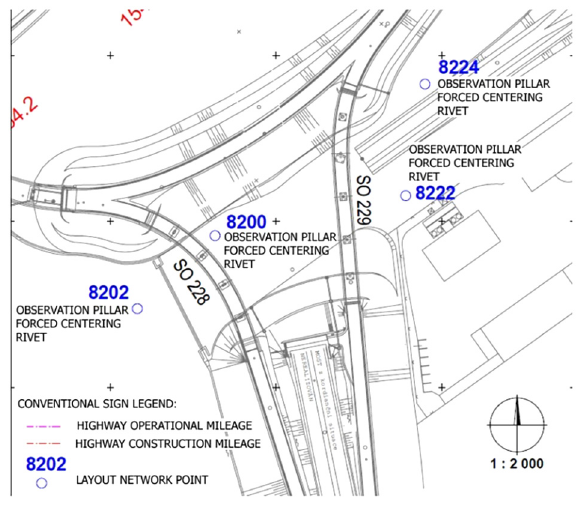
Figure 7. Primary surveying